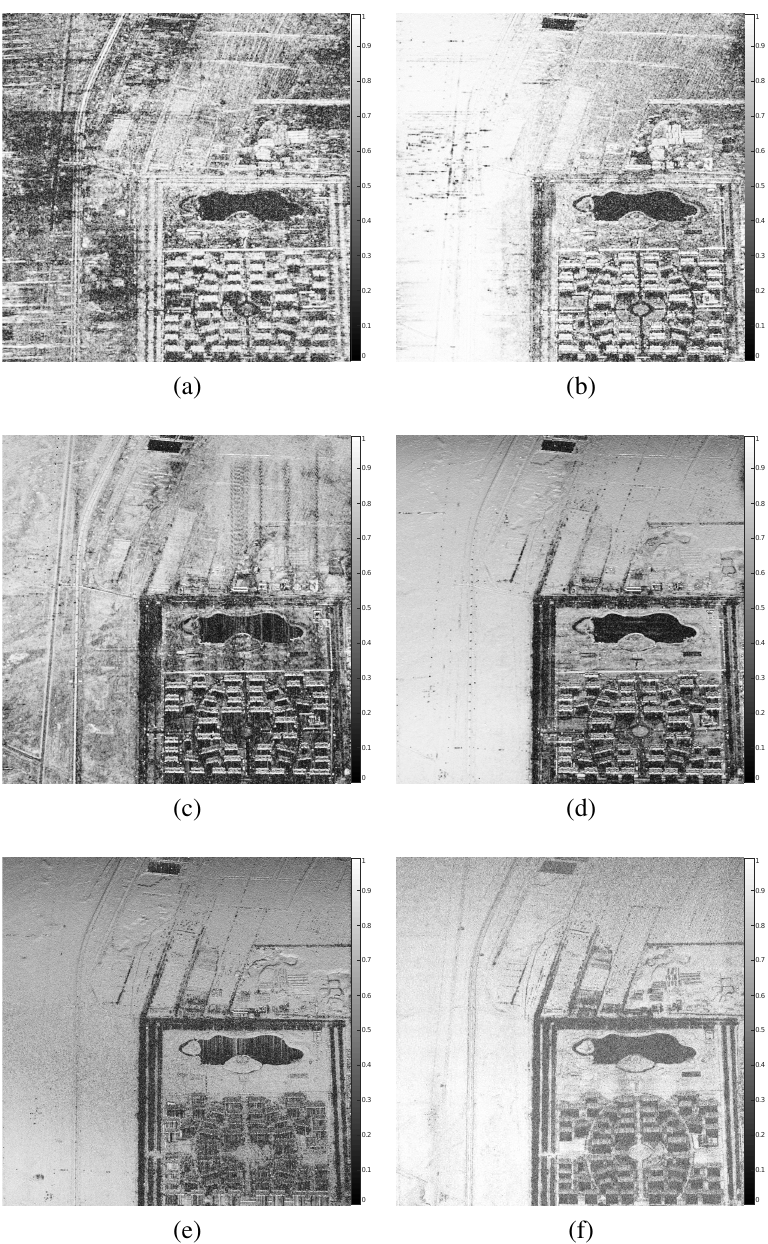
Fig. 3. Coherence maps of the study area. (a) P-band coherence map. (b) L- Figure 4. Coherence maps of the study area. ( a ) P-band. ( b ) L-band. ( c ) S-band. ( d ) C-band. band coherence map. (c) S-band coherence map. (d) C-band coherence map. ( e ) X-band. ( f ) (e) X-band coherence map. (f) Ka-band coherence map.